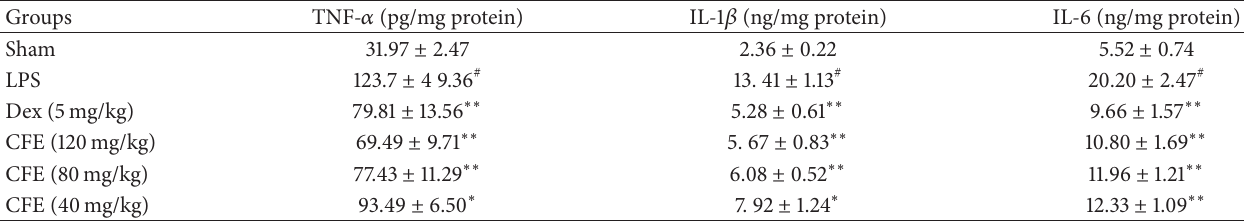
Table 3: The effects of CFE on LPS-induced the levels of TNF- 𝛼 , IL-1 𝛽 , and